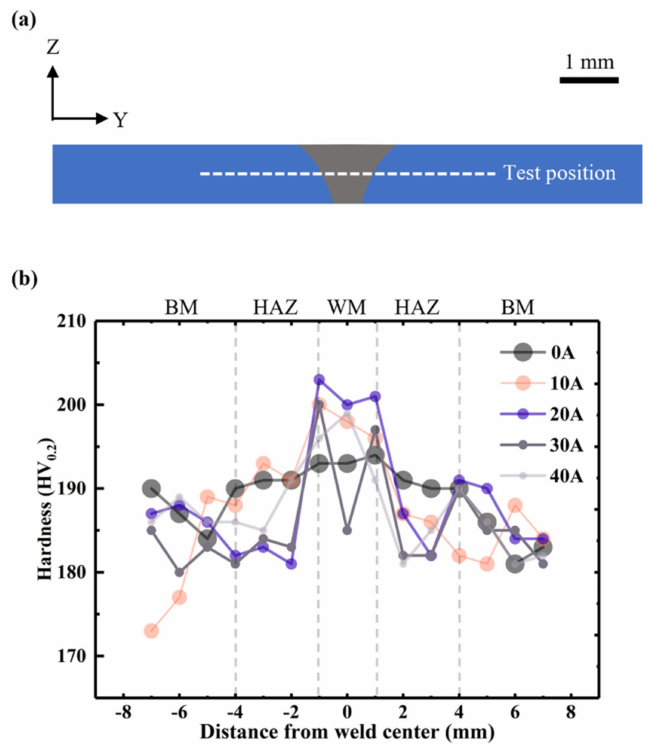
Figure 10. Microhardness distribution in the weld section. ( a ) Microhardness test position. ( b ) Microhardness test